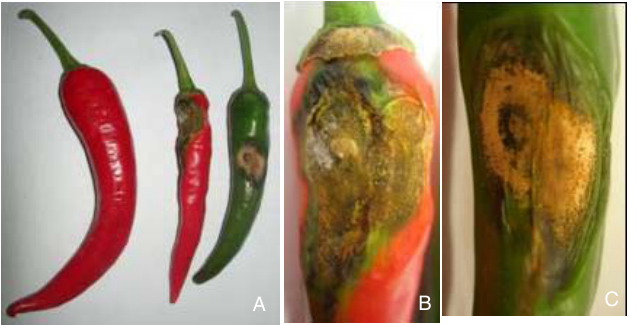
Image 1. (A) Capsicum spp.; non-infected chilli (left) and infected chillies (center and right) attacked by Colletotrichum spp.; (B) & (C) lesions of chillies. (Photos by Ha Kwan Yun,